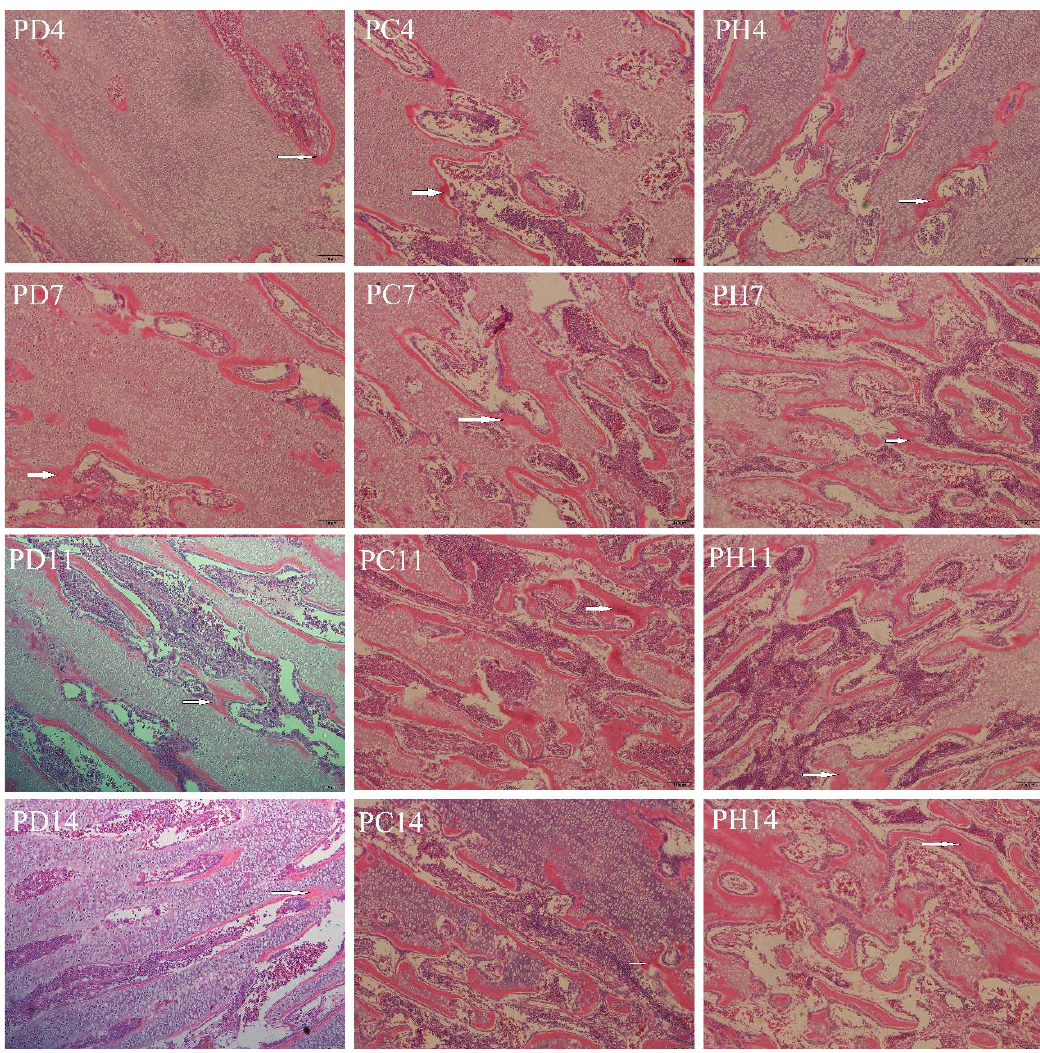
Figure A2. The effect of dietary phosphorus (P) deficiency and high P content on tibia morphology in goslings (×100). 1 The goslings were fed, respectively, with a P deficiency (PD) diet, a control (PC) diet, and a high P content diet (PH). Samples were treated with H.E. staining. Numbers 4, 7, 11, and 14, respectively, refer to the accumulated days after feeding the above feeds by goslings; ×100, magnification ×100. White arrows mark the calcification of the bone matrix (bright red). Dietary P deficiency negatively affected the tibia calcification in goslings. Trabeculae of the tibia of goslings exhibited less mineralized bone levels in the PD group. The goslings in the PC and PH groups had a similar degree of tibia calcification and length of proliferative zones.